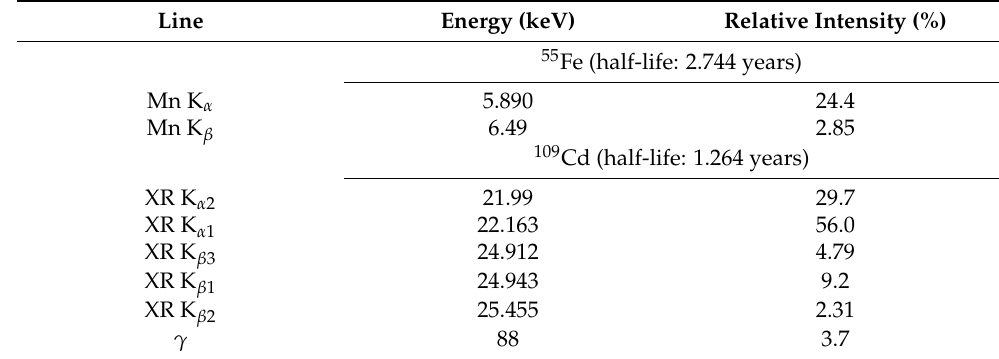
Figure 2. Geometry and working principle of APXS (working distance 10 mm). Table 2. Listed are the energy and relative intensity of characteristic X-rays emitting from radioactive sources ( 55 Fe + 109 Cd) used in APXS for the analysis